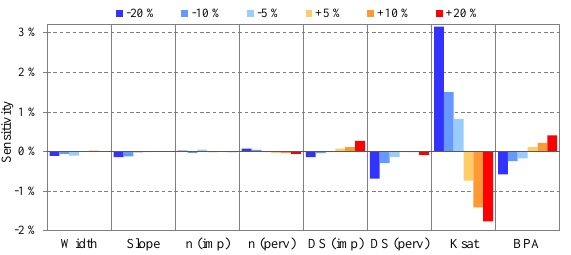
Figure 10. Sensitivity analysis of the SWMM parameters at SHC.